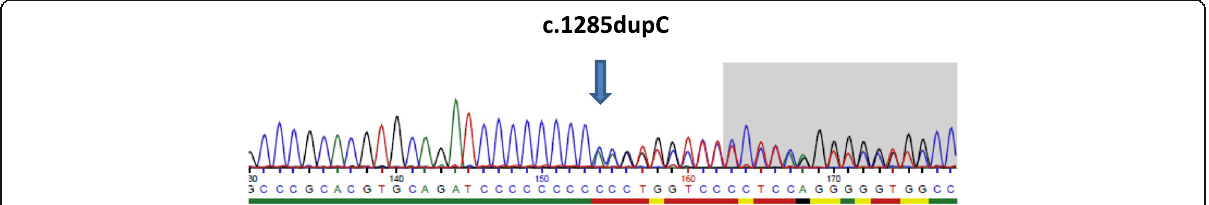
Fig. 3 Sequence electropherogram demonstrating the mutation c.1285dupC (p.His429ProfsX27) within exon 11. The position of the duplicated cytosine is marked by an